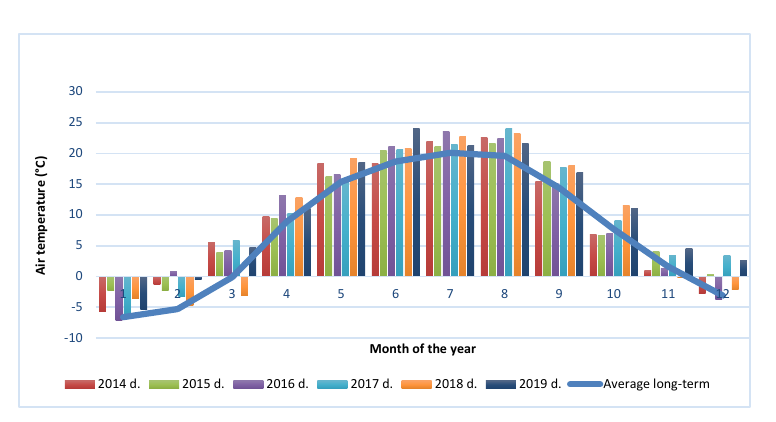
Figure 2 Average monthly air temperature (°C) during 2014–2019.